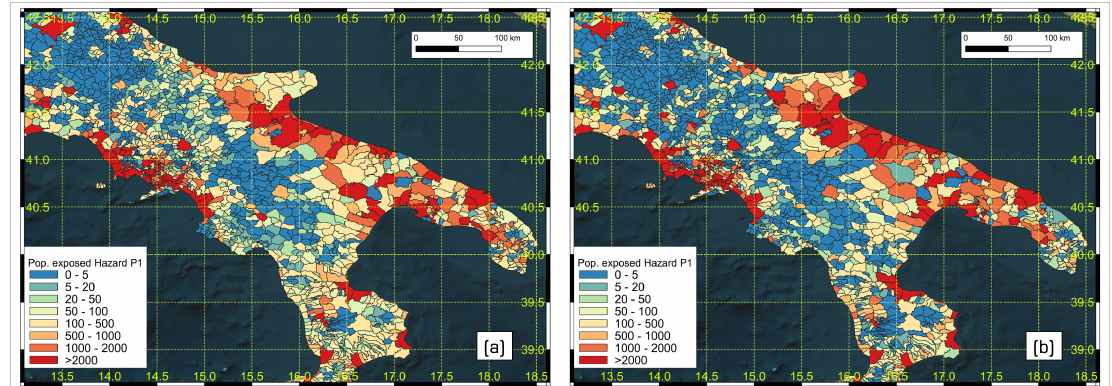
Figure 9. Visual comparison between the number of estimated ( a ) and the number of reference ( b ) population exposed to hazard P1 in Southern Italy, aggregated at municipal scale.